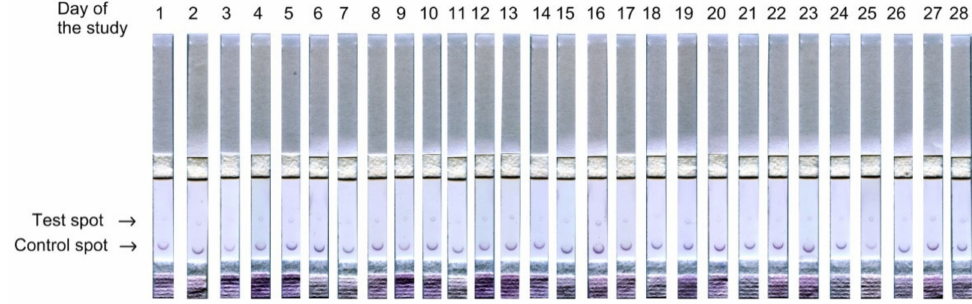
Figure 3. An example of test strips after examining saliva samples from study participant no. 7. It is clearly seen that the intensity of staining is different not only in the upper, but also in the lower